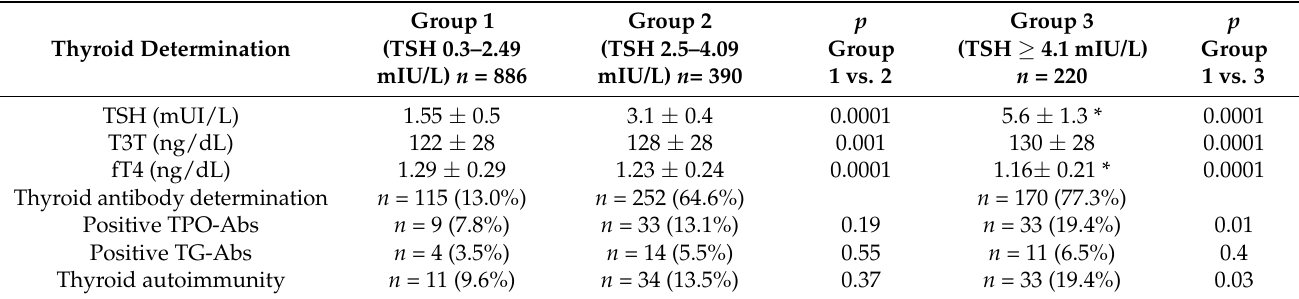
Table 1. Thyroid profile and thyroid antibodies of infertile Mexican women with and without subclinical hypothyroidism using two cut-offs for TSH.